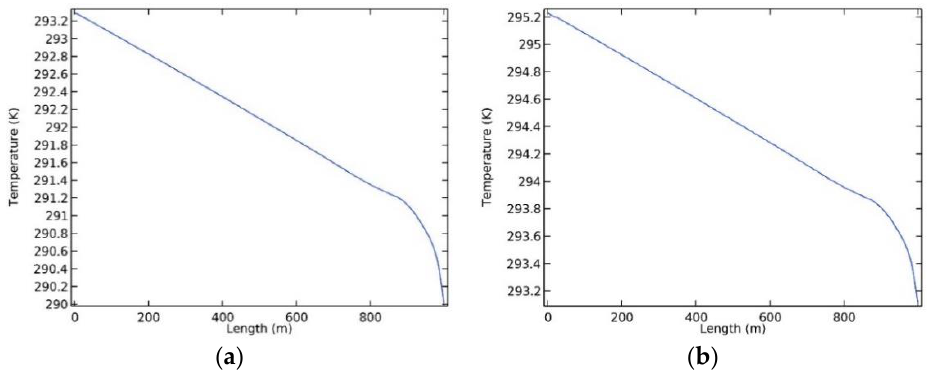
Figure 10. Changes of the internal temperatures of support materials along their centreline: ( a ) Change of the internal temperature of the common sprayed concrete; ( b ) Change of the internal temperature of the heat-insulating materials doped with basalt fibres.